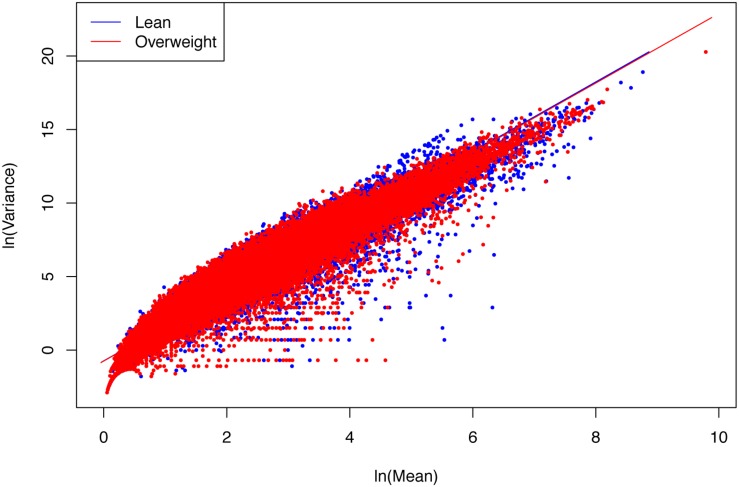
The PLE-III (type-III power law extension) models fitted to the obesity study datasets: more than 10 million points (5407291 lean group + 5134721 overweight) were used to fit the PLE-III models, but here we only randomly selected 100,000 points (50,000 from each treatment) to draw the graphs (so as to accommodate the file size of the figure).